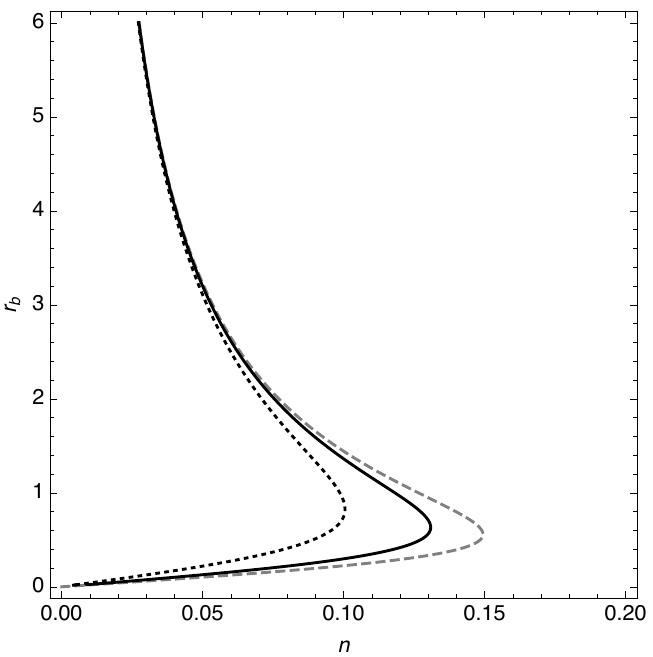
Figure 2 . Plot of the bolt radius r b as a function of n with non-linear electrodynamics parameter γ = 0 . 1 . The (grey) dashed line corresponds to the standard AdS-Taub-bolt solution with v = 0 and n AdSTb = 0 . 149 l , whilst the (black) solid and dotted lines correspond to v = 1 / 2 and v = 1 max respectively; in these two cases, the maximum allowed value for n is always smaller than n AdSTb